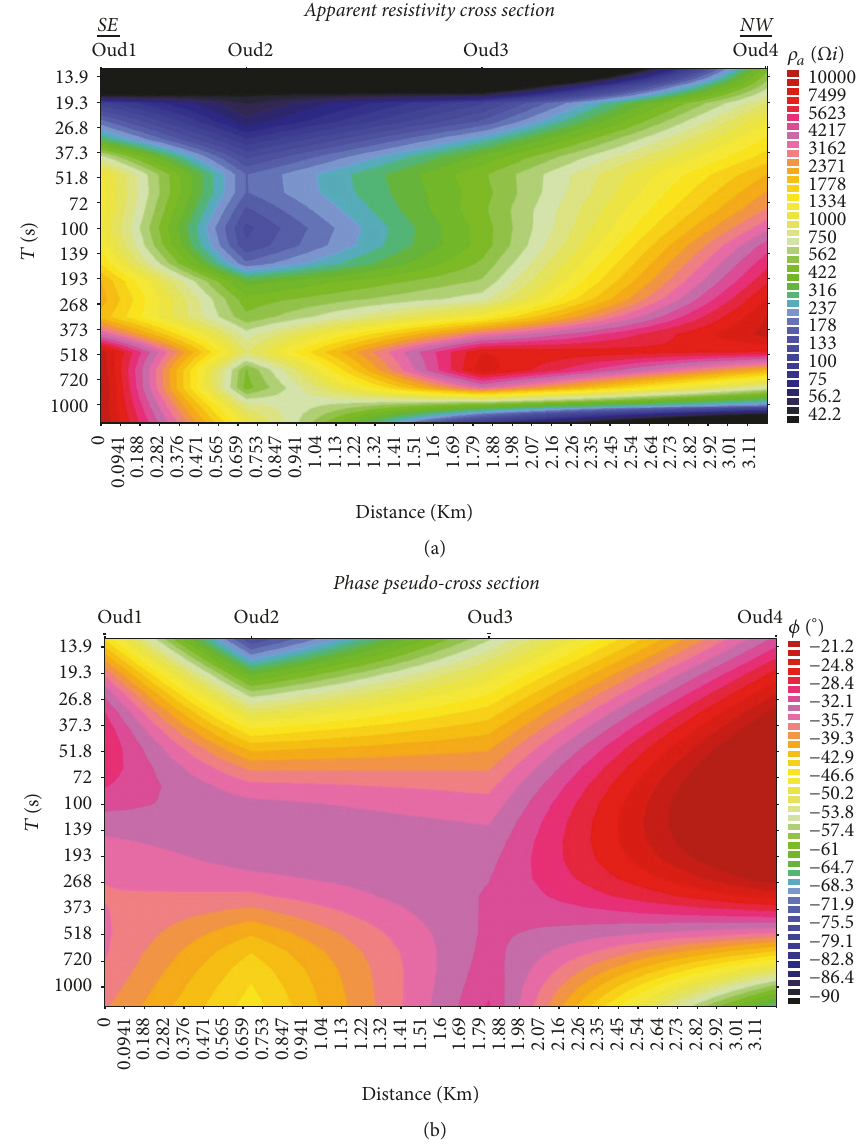
Figure 12: Apparent resistivity (a) and phase (b) pseudosection of Oudou